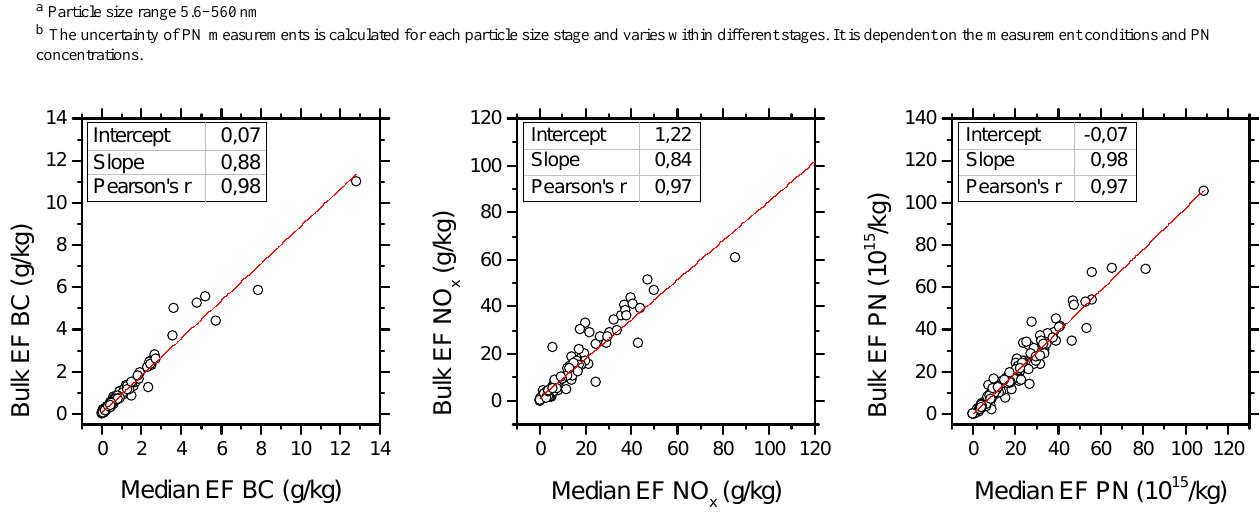
Table 1. Measurement instruments, their time resolutions, sampling flows and measurement uncertainties. Instrumentation Species measured Time resolution Instrument flow Measurement uncertainty Carbocap GMP343 (Vaisala) CO 2 2s 7Lmin − 1 3ppm Aethalometer AE33 (Aerosol d.o.o.) BC 1s Nitric Oxide Monitor and an NO 2 con- verter (models 410 and 401 of 2B Tech-